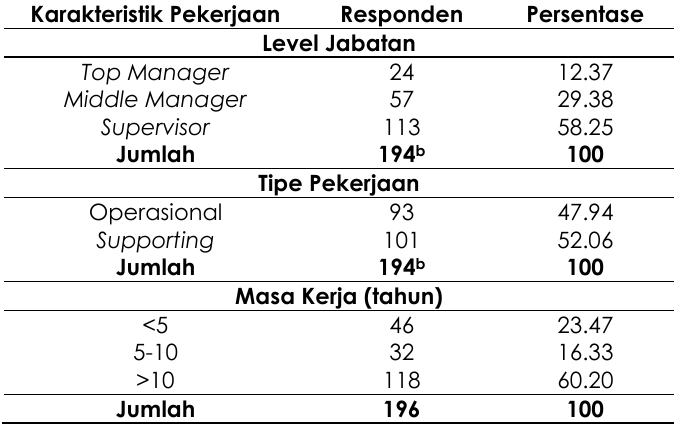
Tabel 2. Karakteristik pekerjaan